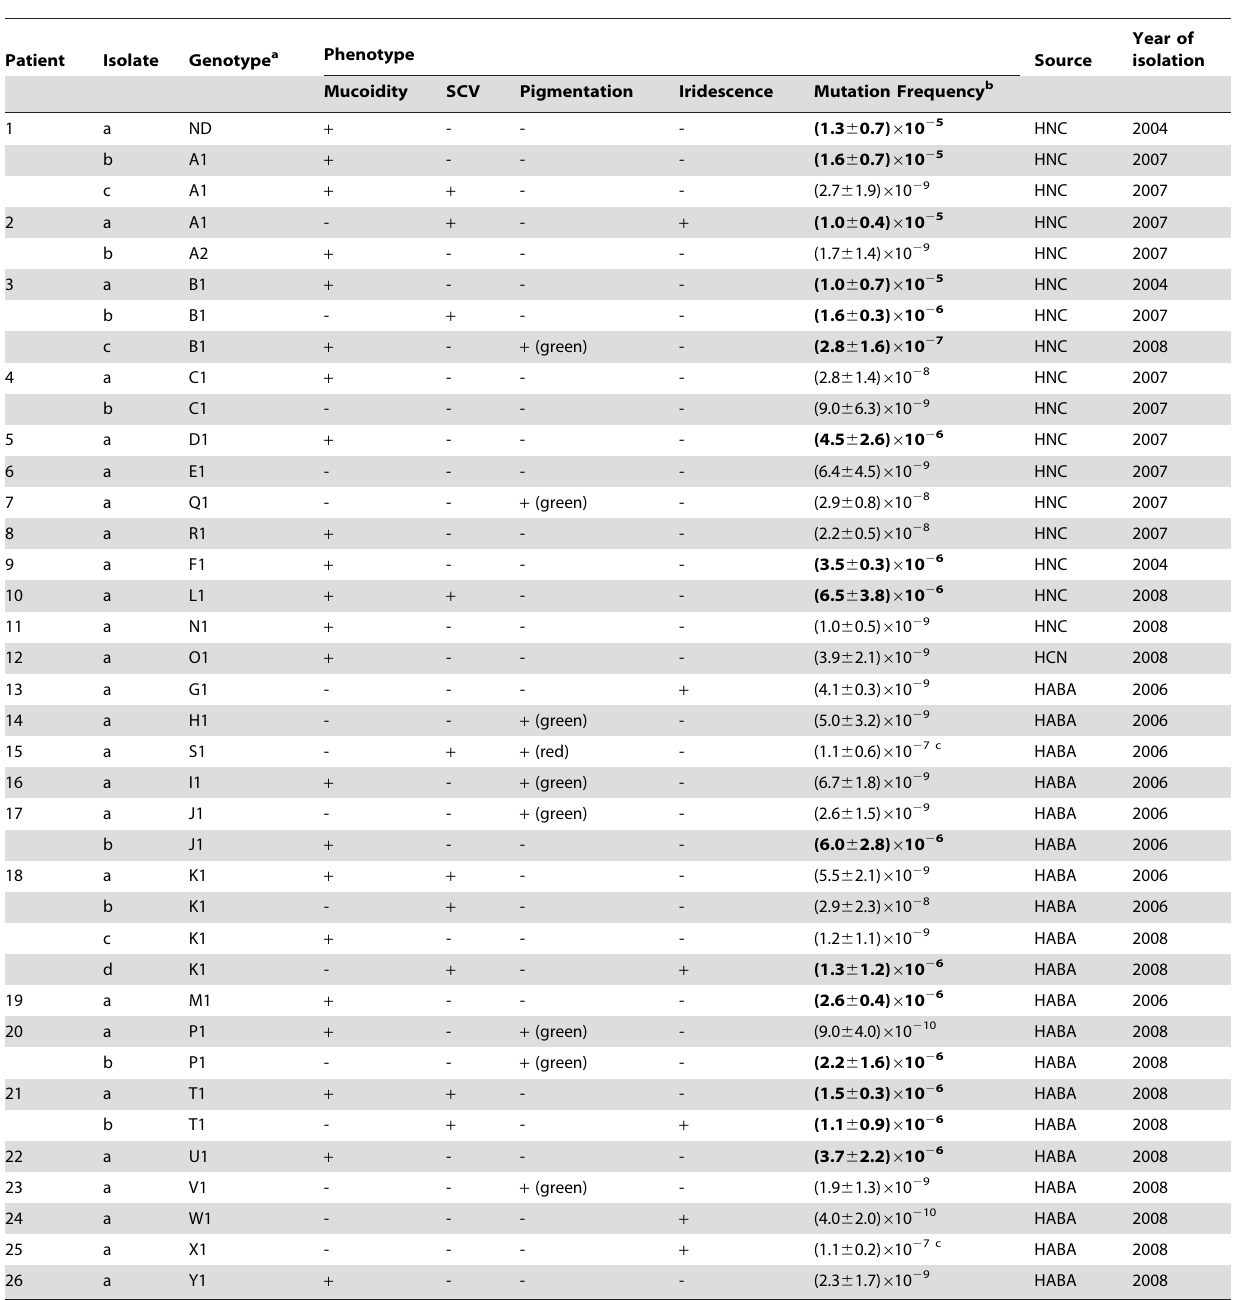
a All isolates were genotyped by PFGE using the SpeI enzyme. b Mutation frequency was measured as the occurrence of spontaneous resistance to rifampin 100 m g/ml. c Isolates 15a and 25a with mutation frequencies nearly under the breakpoint ( $ 2 6 10 2 7 ) were discarded to be mutS or mutL deficient strains by gene sequencing (see Table 2). SCV, Small Colony Variant; ND, not determined; HNC, Hospital de Nin ˜ os de Co´rdoba; HABA, Hospital Alema´n de Buenos Aires. Those isolates with mutation frequencies $ 2 6 10 2 7 were defined as hypermutators and indicated by bold type. Mutation frequencies for PAO1 reference strain and MPAOMS and MPAOML hypermutator strains were (2.4 6 1.3) 6 10 2 8 , (2.8 6 1.6) 6 10 2 6 and (1.3 6 0.6) 6 10 2 6